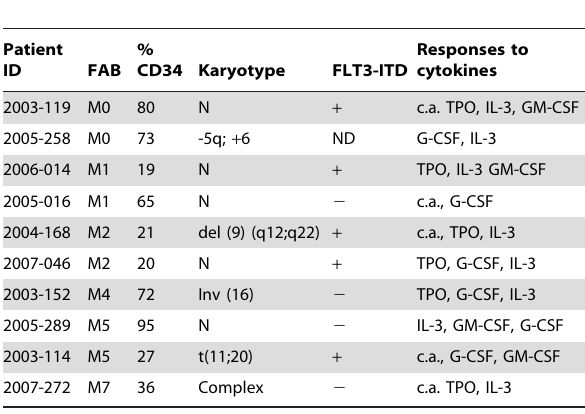
Table 1. Summary of clinical parameters of AML patients used in this